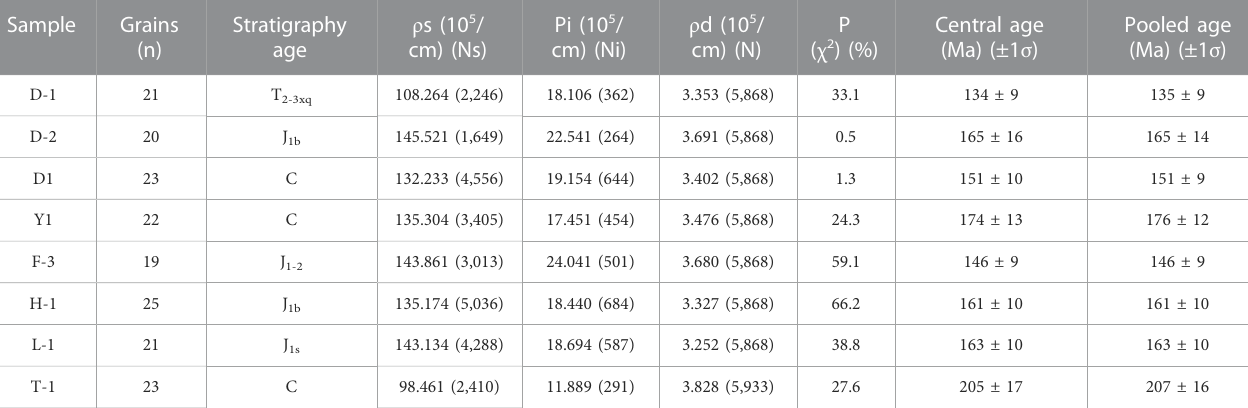
TABLE 3 Zircon fi ssion track data of the northern Junggar